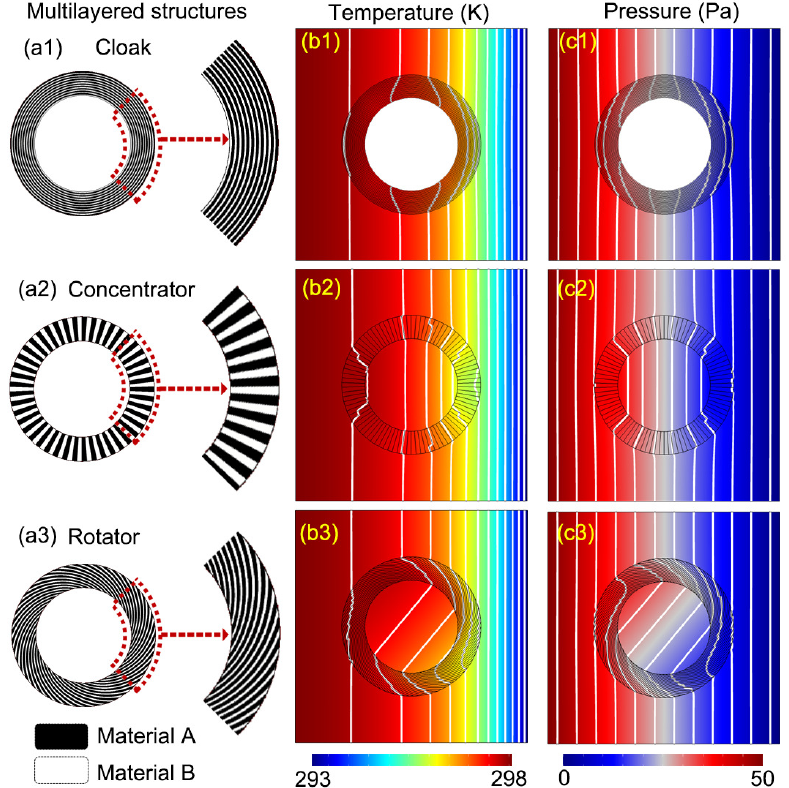
Figure 4. Multilayered structures for convective metamaterials in a Hele–Shaw cell: ( a1 – a3 ) show the structures of the cloak, the concentrator and the rotator made of two alternating materials (Materials A in black and Material B in white), respectively; ( b1 – b3 ) give the simulation results of the temperature distributions for these three devices; ( c1 – c3 ) give the corresponding pressure